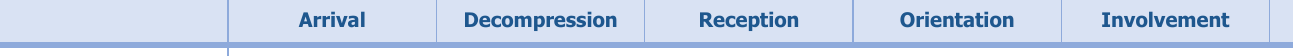
Table 2. Experience Journey Map